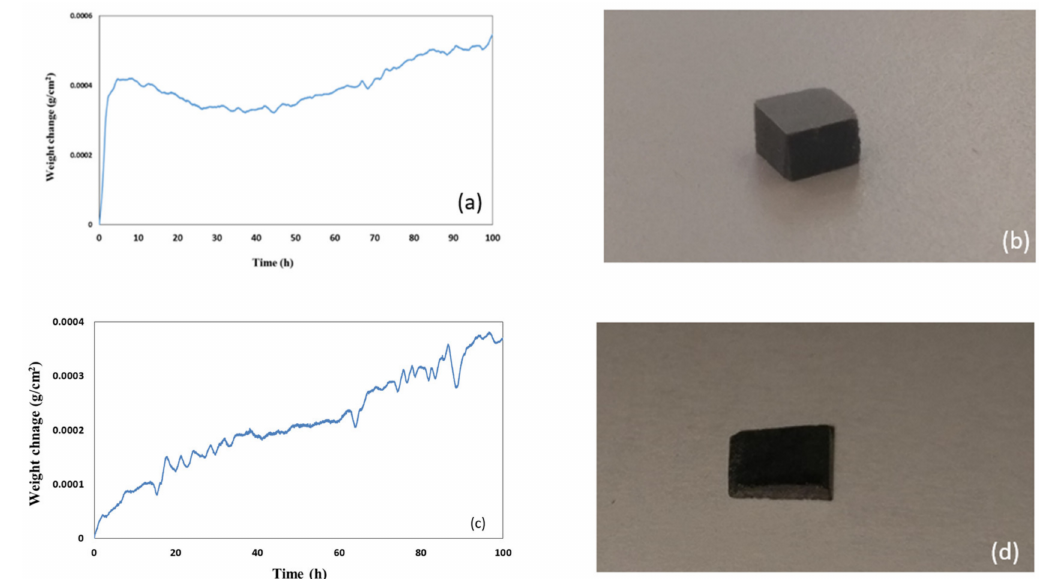
Figure 7. Weight change data and oxidised specimens after isothermal oxidation at 800 ◦ C ( a , b ) alloy MG5, ( c , d ) alloy MG6.